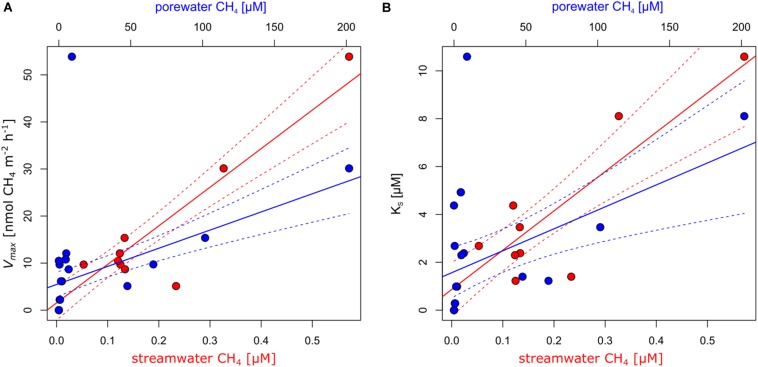
Methane (CH4) oxidation (MOX) kinetics constants maximum reaction velocity [Vmax; (A)] and concentration at half Vmax [KS; (B)] were significantly related to streamwater (red) and porewater (blue) CH4 concentrations. The lines represent linear regression models, and the dashed lines represent the respective 95% confidence interval.